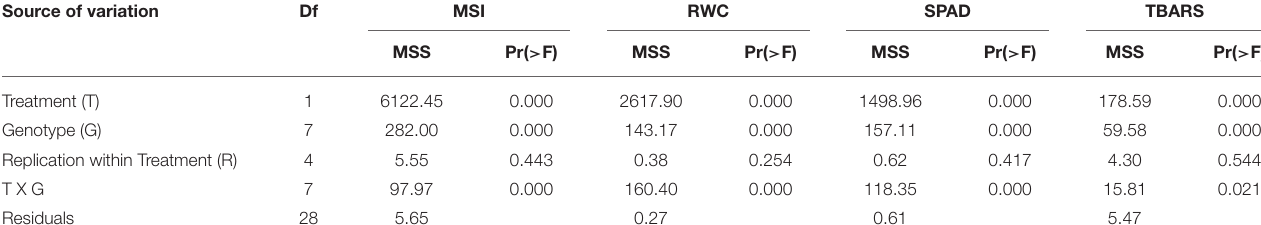
TABLE 4 | The mean square values of the treatments (T), genotypes (G), and the treatment–genotype interaction (T × G) along with their errors and significance indicated by the value of p . Source of variation